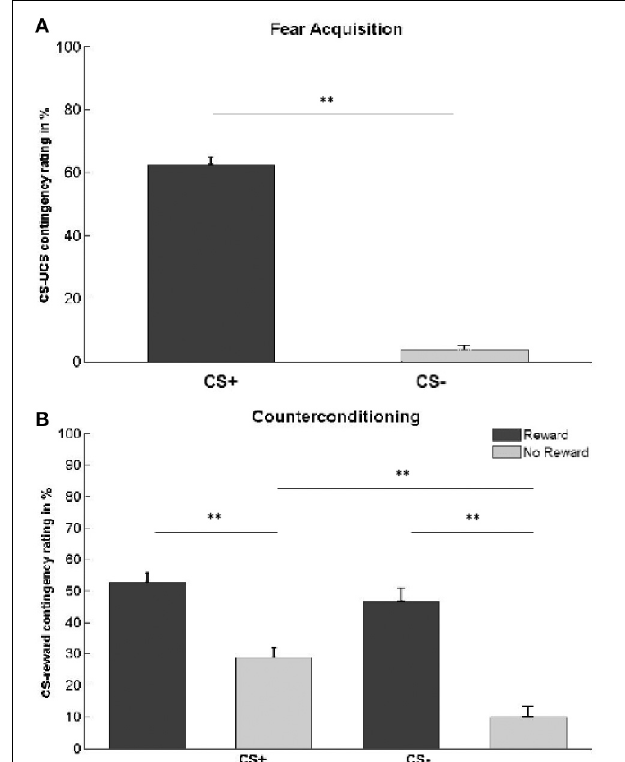
FIGURE 2 | Contingency awareness ratings. (A) Subjects’ estimation of the percentage of trials in which each CS type was followed by the UCS. Actual contingencies were 60% for CS + , 0% for CS − . (B) Subjects’ estimation of the percentage of trials in which each CS type was followed by reward. Actual contingencies were 60% for rewarded stimuli (dark gray bars), 0% for unrewarded stimuli (light gray bars). Asterisks indicate significant difference ( ∗∗ p < 0 . 01). Error bars represent standard error.